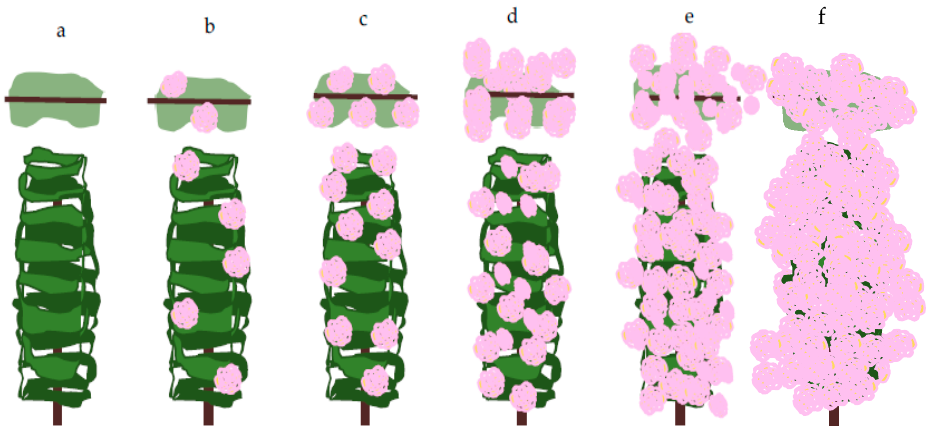
Figure 1. The chosen phenology stages on a scale 0–5 in climber roses, where: ( a ) BBCH 07—starting of bud break, first leaf tips appears; ( b ) BBCH 11—the first light green and/or bronze leaves pair develops, not yet at full size; ( c ) BBCH 60,601—start of flowering (about 10% of flowers open); ( d ) BBCH 63,605—full of flowering (at least 50% of flowers open); ( e ) BBCH 69,609—end of flowering (after all petals shedding).